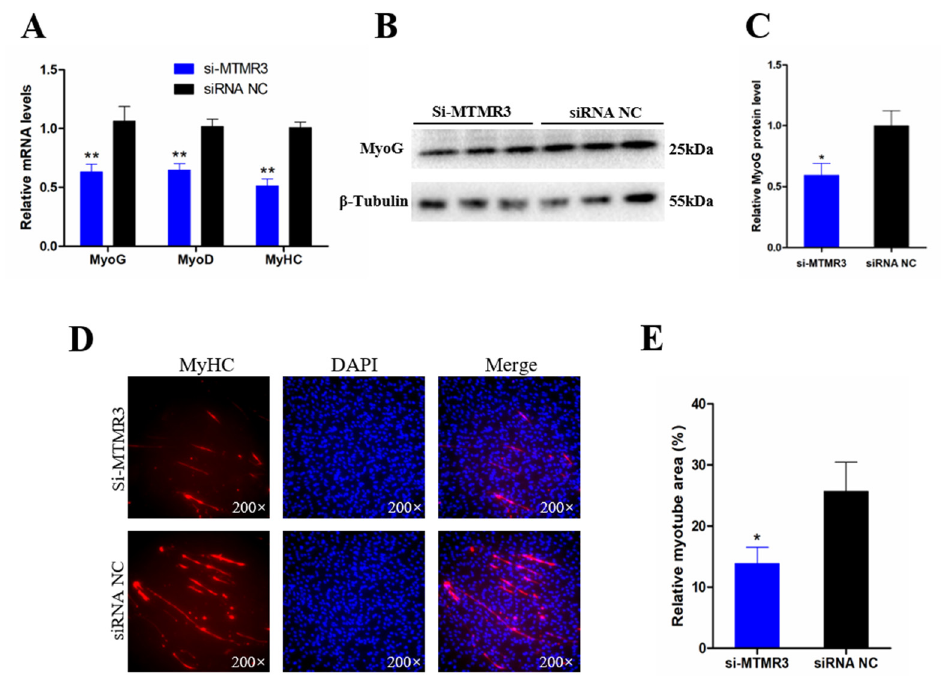
Figure 6. Knockdown MTMR3 represses chicken SMSCs differentiation. ( A ) The mRNA levels of muscle cell differentiation marker genes were detected by qRT-PCR in SMSCs after MTMR3 knockdown. ( B ) Western blotting results of MyoG in SMSCs after transfection with MTMR3 siRNA1. ( C ) The relative protein level of MyoG in SMSCs after inhibition of MTMR3. ( D ) MyHC immunofluorescence staining after the transfection of MTMR3 siRNA1 in SMSCs. ( E ) Relative myotube area of chicken SMSCs following MTMR3 knockdown. Results are shown as mean ± SEM, and the data are representative of at least three independent assays. Student’s t -test were used to compare expression levels among different groups. * p < 0.05; ** p < 0.01.